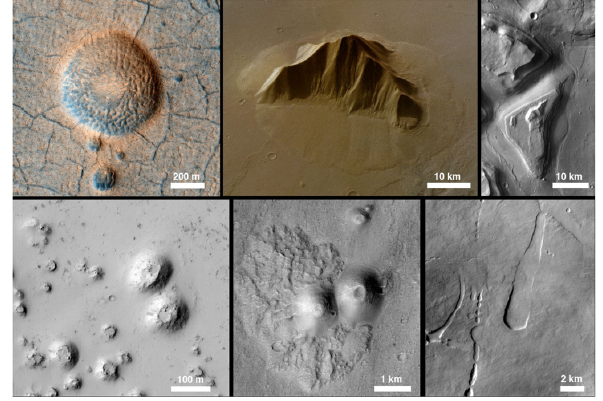
Fig. 5. Orbital images of examples of classes of potential targets for muon radiography on Mars. Top left: aputative pingo (ice-cored mound) in Utopia Planitia (HiRISE). Top middle: perspective view of a massif in the Eastern Hellas region with surrounding ice-rich lobate aprons. The target for muon radiography would be the aprons surrounding the massif, which are up to 1km thick in places. (Ele- vation and image data from HRSC). Top right: mesas in Hydraotes Chaos, once a source of outflow flood waters, and potentially a host of remnant aquifers (THEMIS visible). Lower left: rootless cones on platy lava flows in Elysium Planitia (HiRISE). Lower middle: Enigmatic edifices in Hydraotes region that may be rootless, or con- nected to a vent system (HiRISE). Lower right: chains of collapse pit on Ascraeus Mons. Areas between pit chains may contain lava tubes or caves in the subsurface.